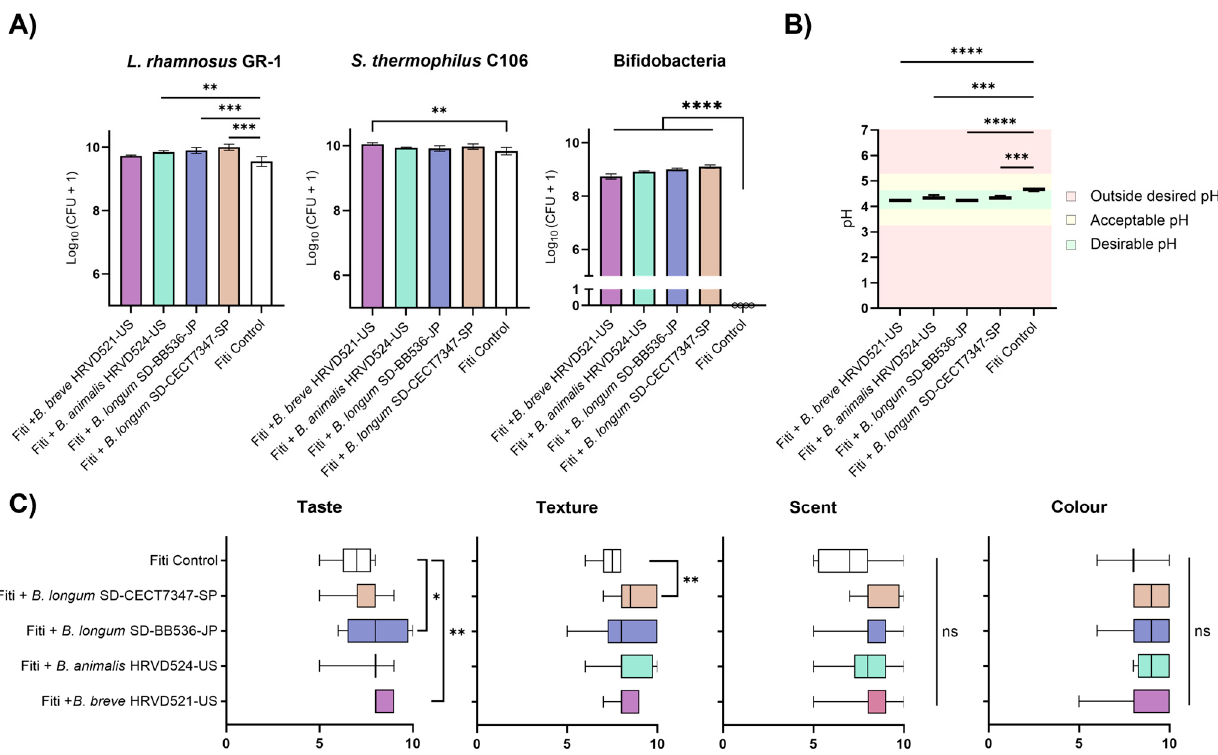
Figure 2. Supplementation of probiotic bifidobacteria improves the quality of Fiti yogurt. ( A ) CFU of L. rhamnosus GR-1, S. thermophilus C106, and Bifidobacterium spp. per yogurt sample plated on appropriate agar ( n = 4). CFU data are displayed as the geometric mean of log 10 (CFU + 1) ± SD. ( B ) pH of yogurt samples 24 h after production ( n = 4). ( C ) Sensory properties of the yogurt samples ( n = 12). In the box plot diagrams ( B , C ), boxes represent the first and third quartile values, while black lines denote medians; whiskers encompass maximum and minimum values. All other data are displayed as the mean ± SD, unless otherwise stated. Statistical analyses shown are from a one-way ANOVA or Kruskal–Wallis test. * p < 0.05; ** p < 0.01; *** p < 0.001; **** p < 0.0001; ns, not